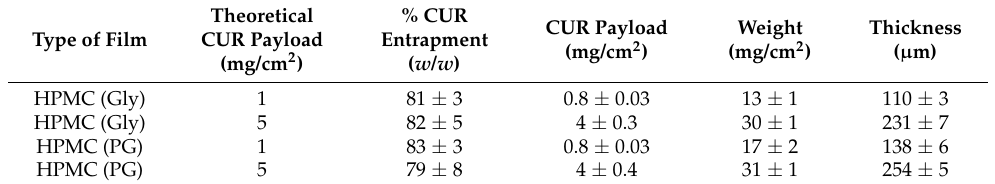
Table 1. Physical characteristics of HPMC (Gly) and HPMC (PG) films ( n = 10, mean ± stdev). Type of